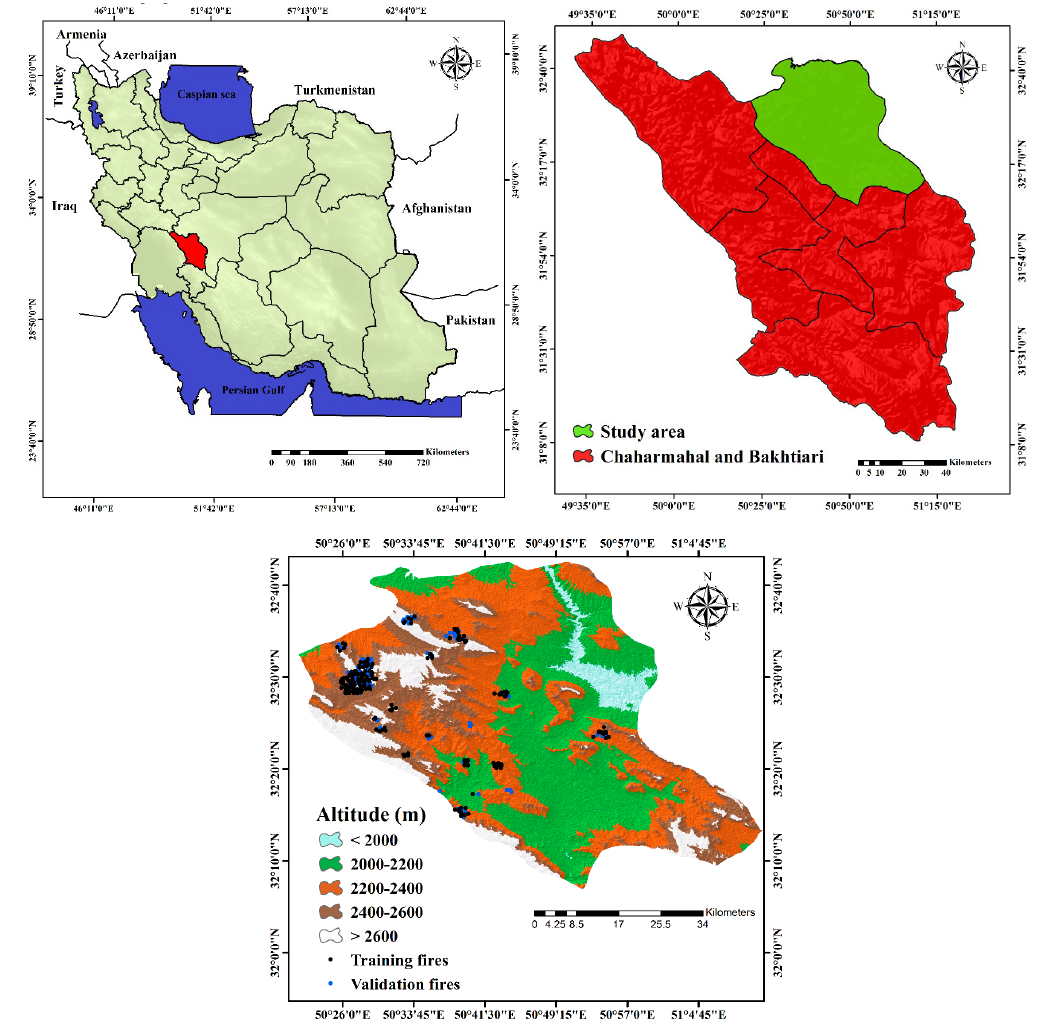
Figure 1. Study area with the fire locations.